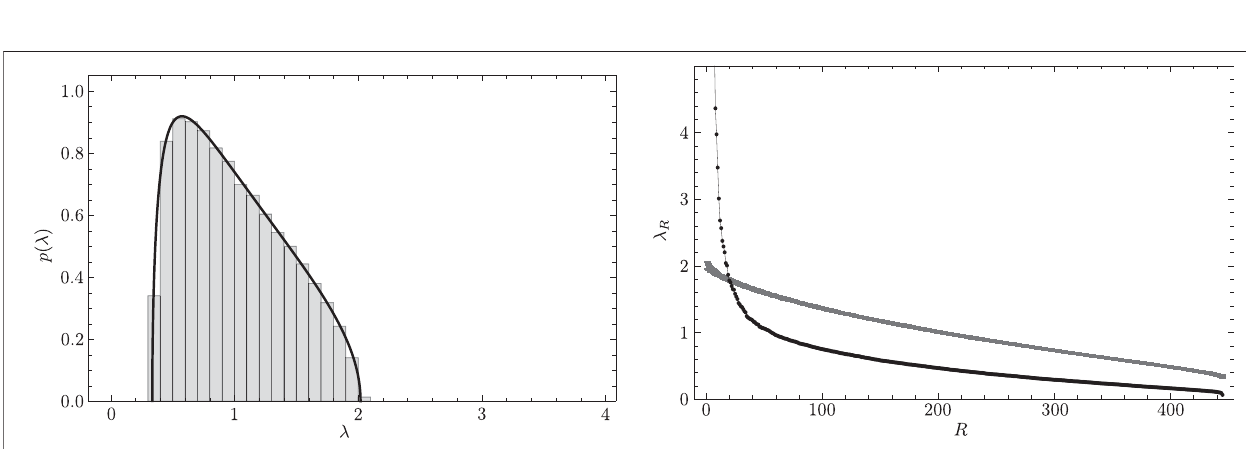
FIGURE 3 | (Left) Distribution p ( λ ) of eigenvalues λ of the equal-time cross-correlation matrix constructed from randomly shuf fl ed time series. The solid line represents the Mar ˇ cenko-Pastur distribution derived under RMT as the theoretical curve given by Eq. 5 . (Right) Scree graph of eigenvalues. The abscissa represents eigenvaluerankings R ,and theordinate represents empirically obtained eigenvalues λ R . The curve with errorbars depicts thesimulateddistributionof eigenvalues using random shuf fl ing (RS). To obtain this curve, we repeated this manipulation 20 times and calculated the mean value and standard deviation. Each error bar represents three times the standard deviation. The thin line with fi lled circles depicts the distribution of eigenvalues of the empirical equal-time cross-correlation matrix. The meaningful part can be obtained by comparing these two distributions. If the upper bound for eigenvalues derived from the randomly shuf fl ed cross-correlation matrix is denoted as λ max , then λ 1 > λ 2 > ... > λ 19 > λ max (cid:2) 1 . 7947. Hence, 19 meaningful components should be retained for this data